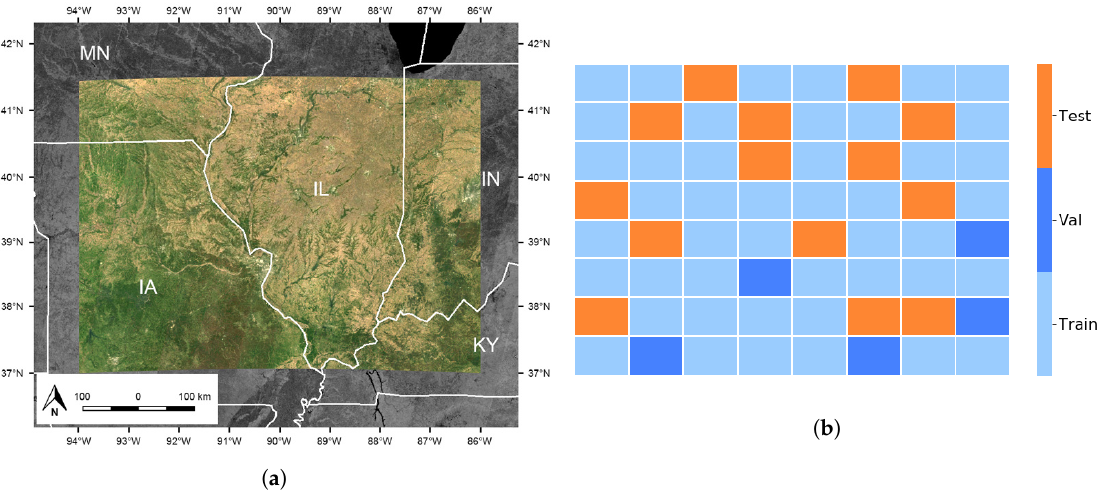
Figure 2. ( a ) Landsat 8 median composite showing our study area in the Midwestern United States for the year 2017. ( b ) Spatial split of the dataset into training, validation, and test sets for method evaluation. The geographic split reduces spatial correlations that may lead to inflated validation and test set accuracies. The non-test set is split into 10 folds for cross-validation; only one fold (darker blue) is visualized